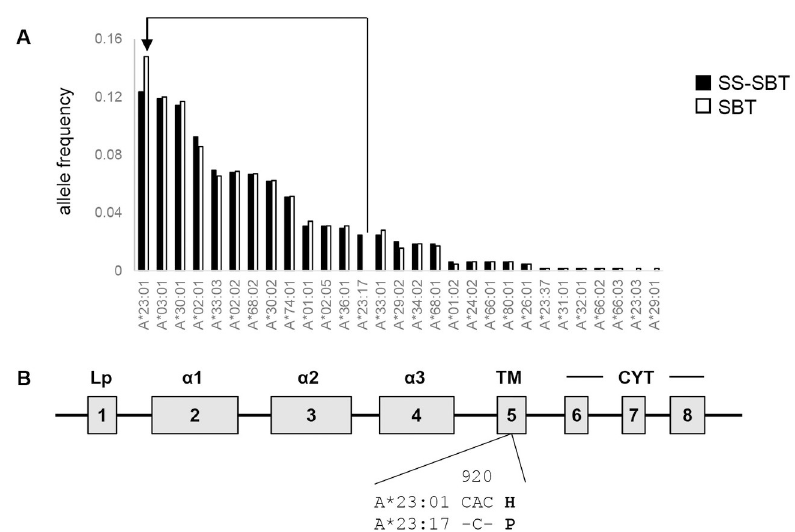
Fig 1. HLA-A allele frequencies in HIV-1 infected individuals in Ghana. A. HLA-A allele frequencies assigned by SS-SBT (filled) and SBT (open) are shown. An HLA allele pair showing discrepancy between the typing methods ( A � 23 : 17 by SS-SBT and A � 23 : 01 by SBT) is shown by an arrow-line. B. Schema of HLA class I gene structure. The difference in amino acid sequences between A � 23 : 01 and A � 23 : 17 is